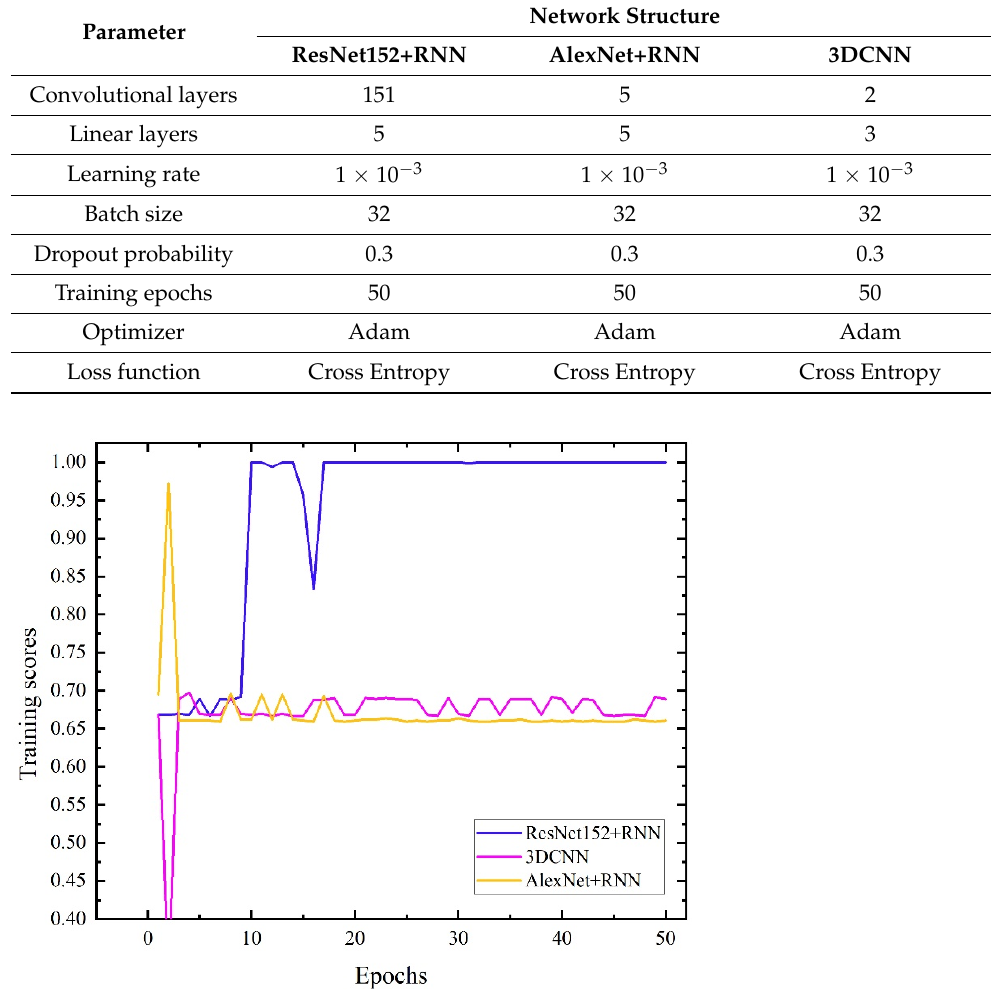
Figure 11. Test data training score curves of the three networks.